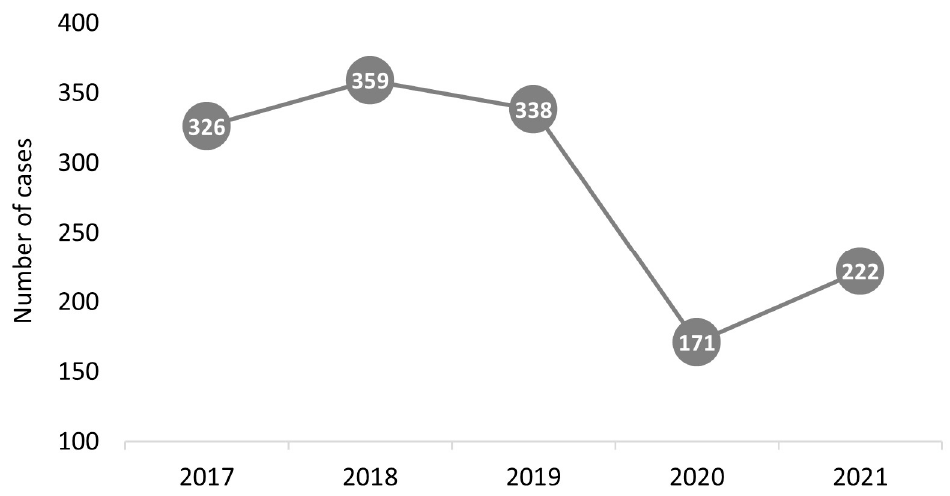
Figure 1. Distribution of pediatric adenovirus cases per year.